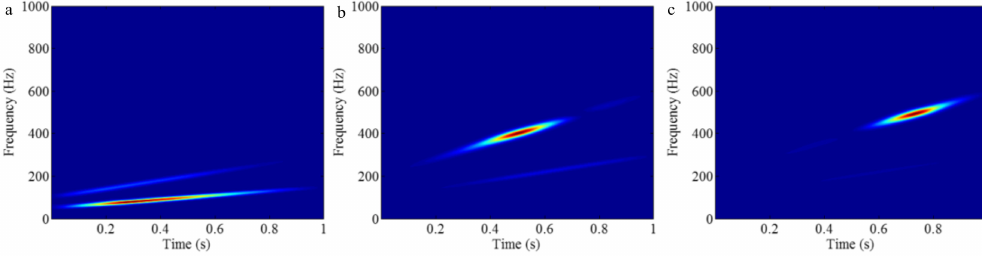
Figure 36. The STFT representations of the Comps 1–3: ( a ) Comp 1; ( b ) Comp 2 and ( c ) Comp 3.